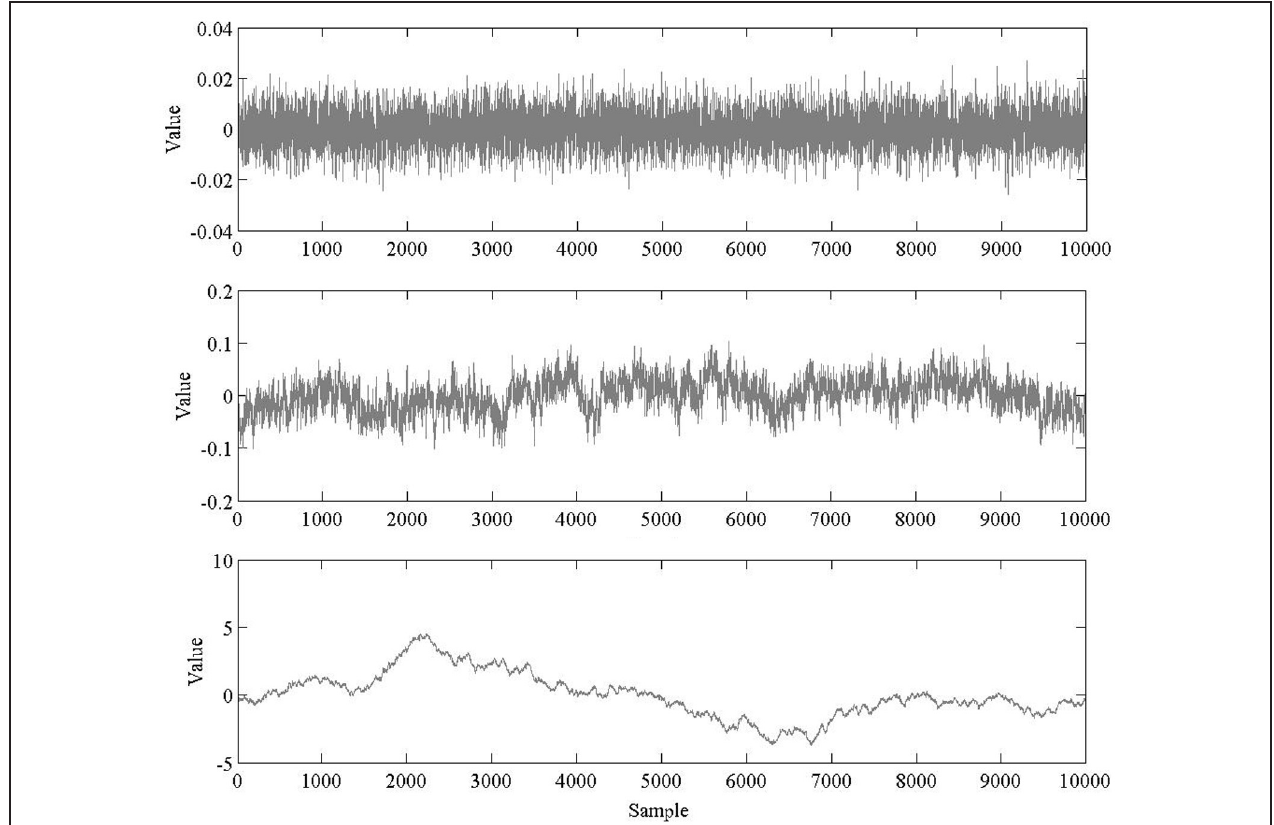
FIGURE 4 | Sample time series of white (top), pink (middle), and brown (bottom) noise.